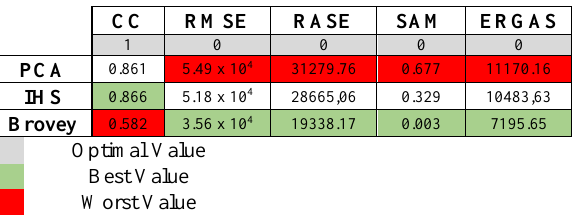
Table 4. Metric results for GÖKTÜRK-2 images